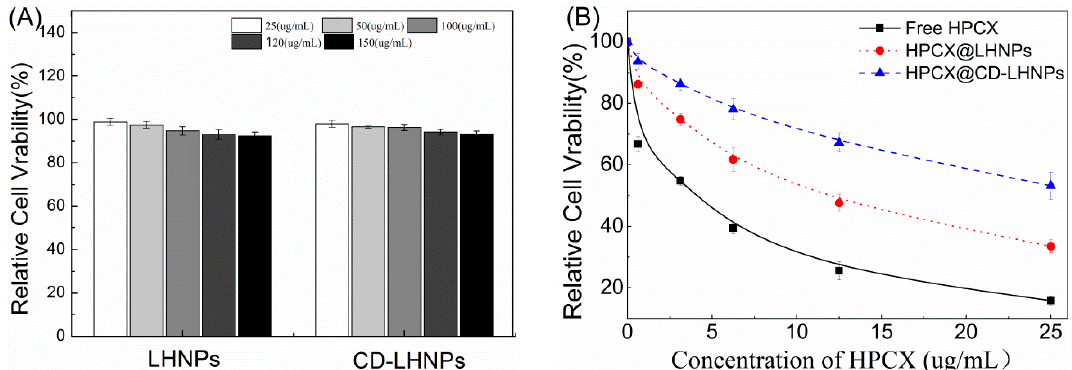
Figure 7. Viability of HeLa cells after 48 h incubation at 37 °C. ( A ) LHNPs and CD-LHNPs at different concentrations; ( B ) Free HCPT, HCPT@LHNPs and HCPT@CD-LHNPs.